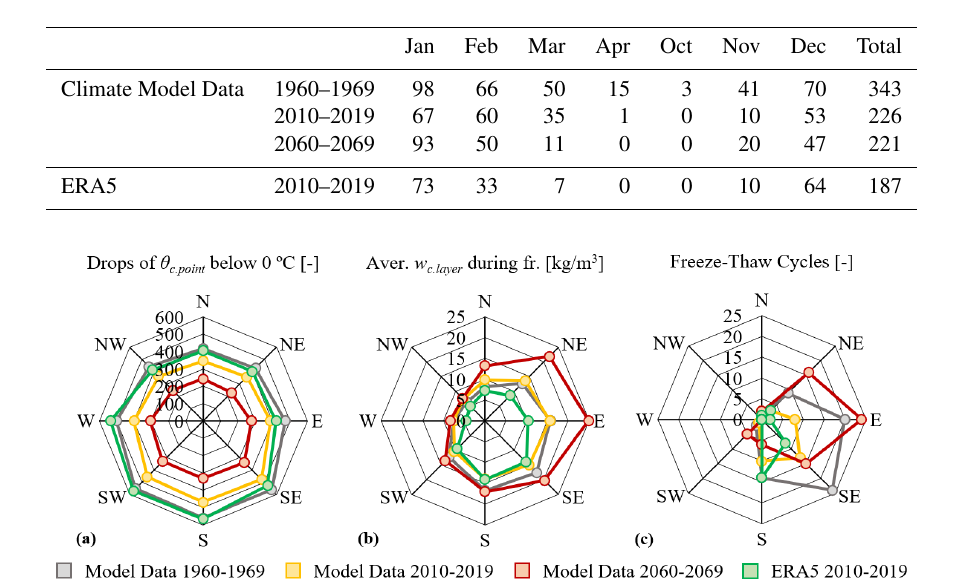
Table 5. Number of freeze-thaw events of a 5mm layer at the exterior side of the southeast-oriented masonry wall. Freezing occurs at a material temperature below 0 ◦ C and a degree of saturation above 0.25. Within the hygrothermal simulations, the indoor air temperature and relative humidity were considered equal to the outdoor ones.